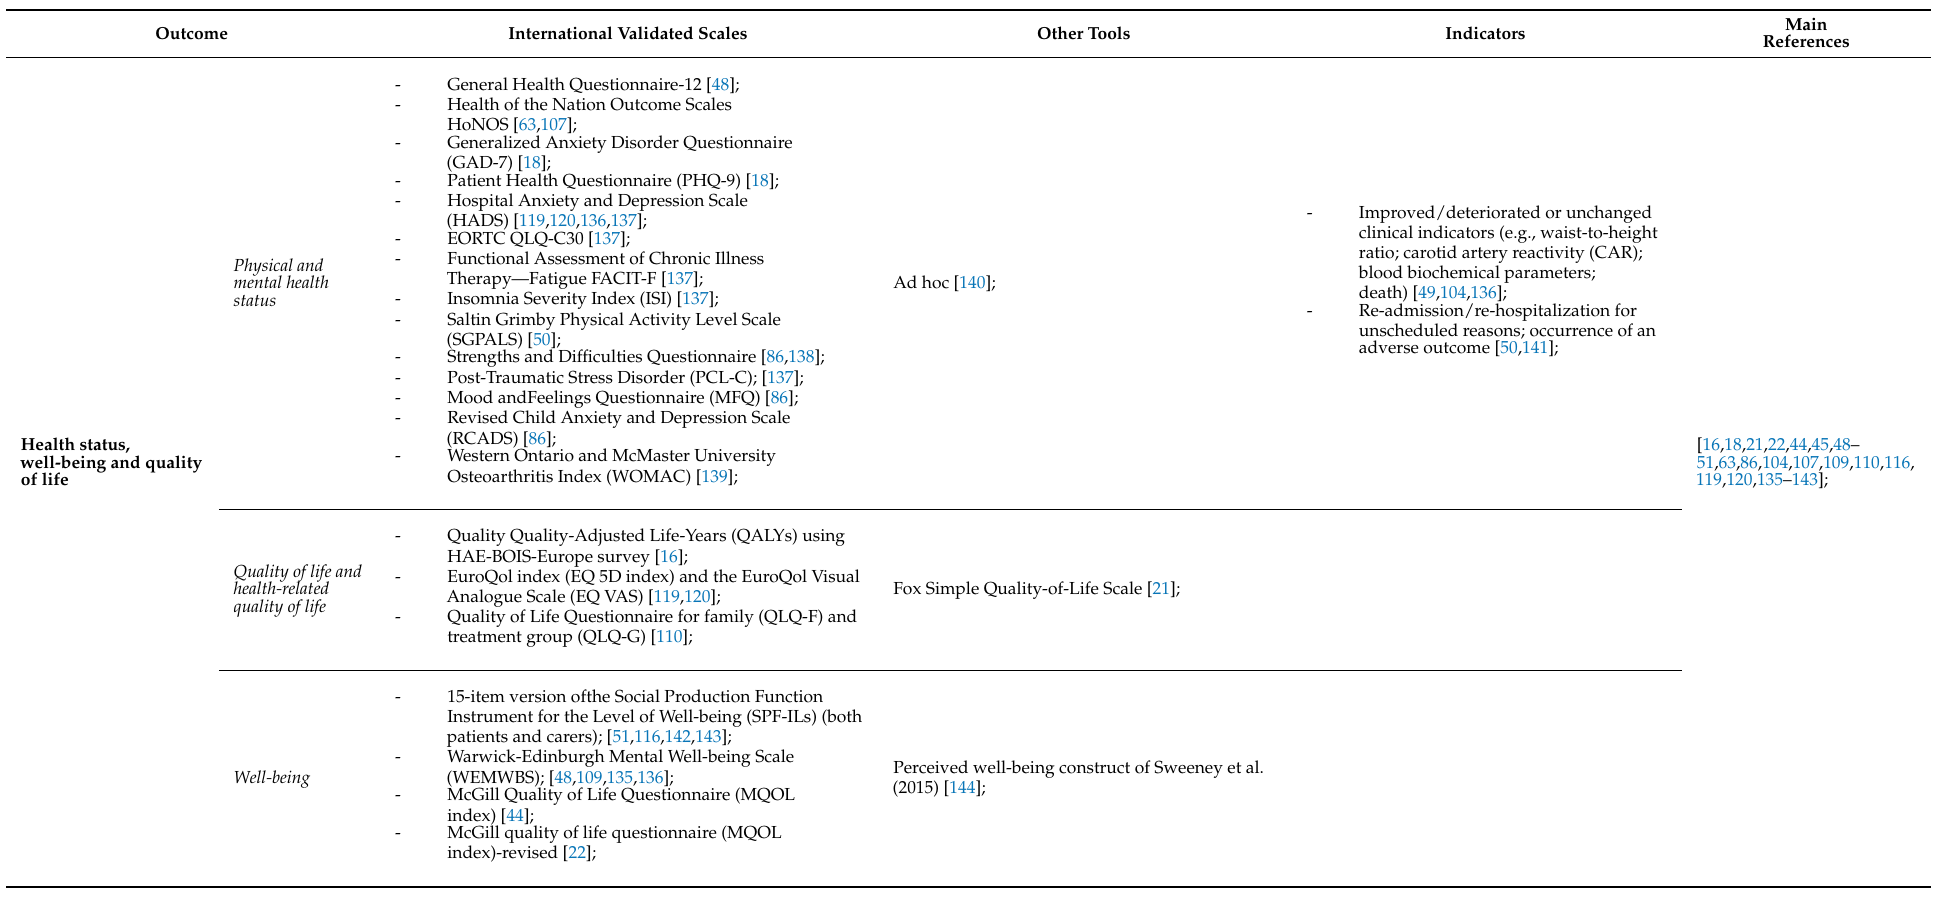
Table 8. Measures and metrics of outcomes for lay